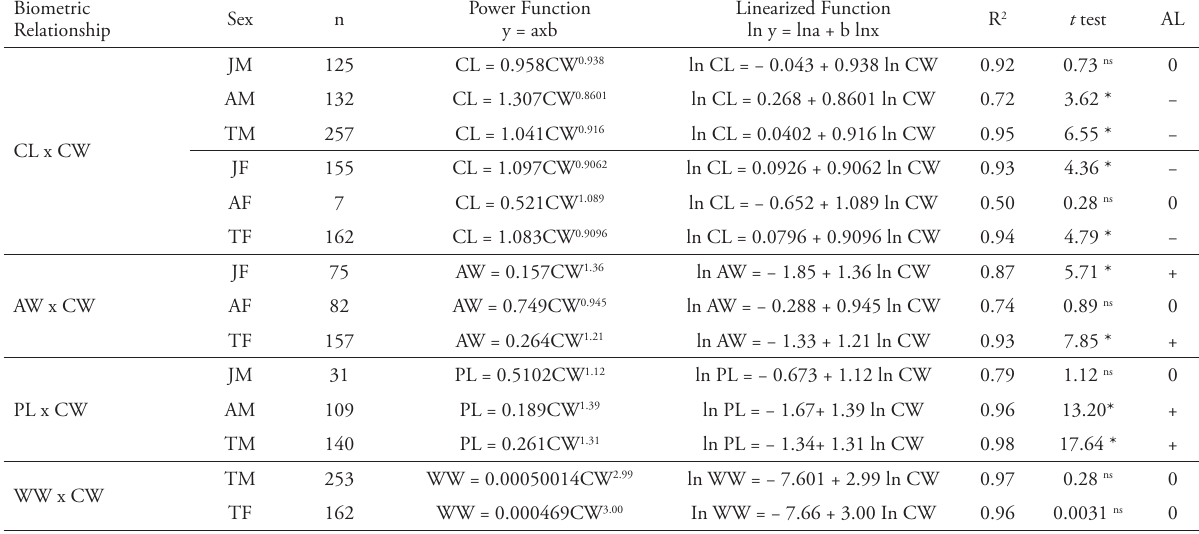
Table 3. Ucides cordatus (Linnaeus, 1763). Results of a regression of each biometric variable, including carapace (CW, width; CC, length), the length of the propodus of the major cheliped (PL, for males), the width of the 5 th somite of the abdomen (AW, for females) and the wet weight (WW), with sex and developmental phase (juvenile and adult) and its growth allometric level (AL), represented by: 0 (isometry), + (allometric positive), and - (allometric negative). AF represents adult females, AM represents adult males, JF represents juvenile females, JM represents juvenile males, n is the number of individuals, TF is the total number of females, TM is the total number of males, and R 2 is the coefficient of